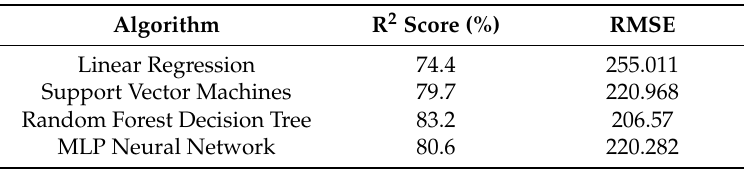
Table 5. Performance metrics of day-ahead predictions.